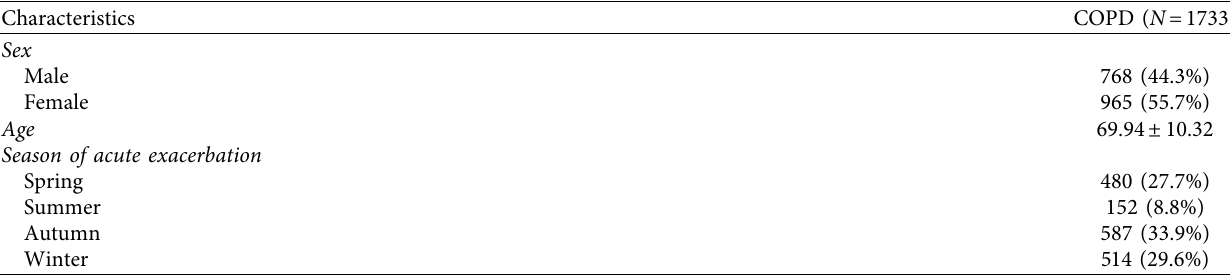
Table 1: Characteristics of patients with